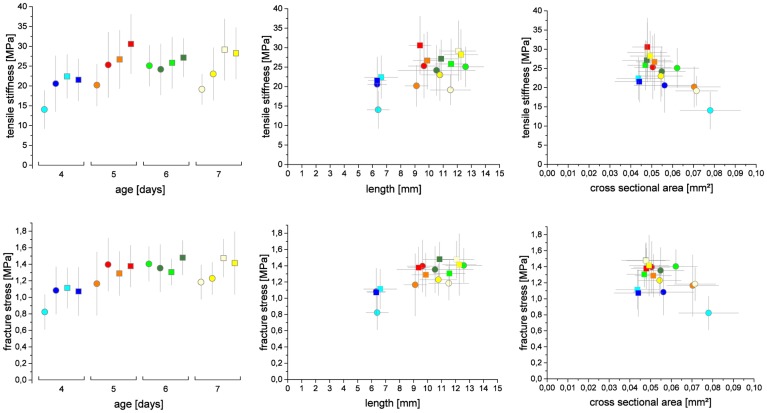
Tensile stiffness and fracture stress of series 1a (round, light symbols), 1b (round, dark symbols), 2a (square, light symbols, 2b (square, dark symbols).Plotted against age, lengths and cross sectional areas. For each set n>18 samples were analyzed respectively.